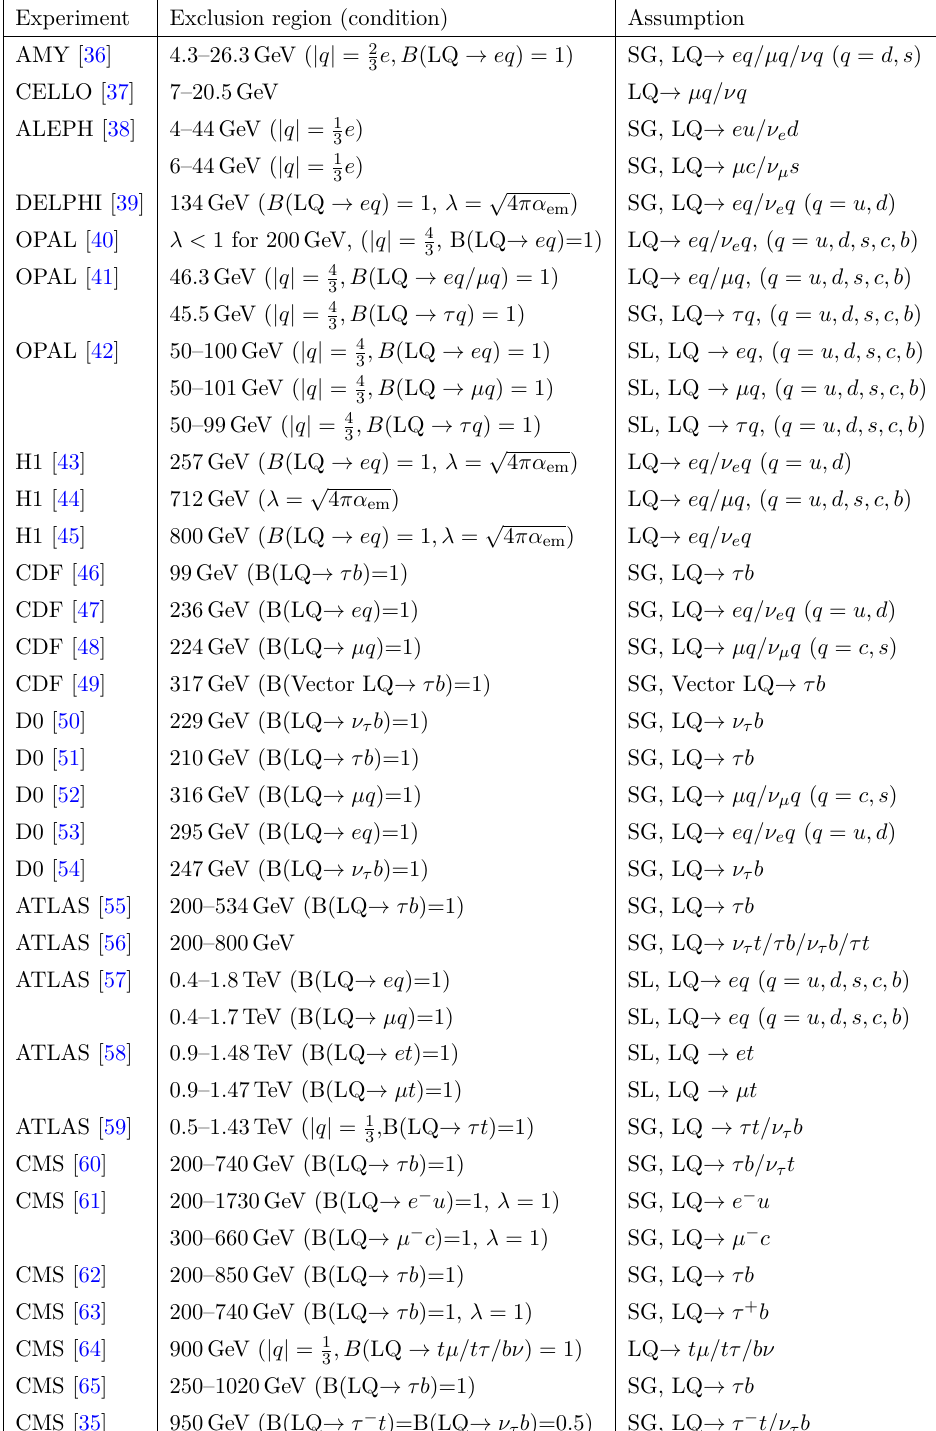
Table 1 . Overview of the experimental searches for the leptoquarks. “SG” represents the assump- tion that a LQ couples to the same generation of fermions. “SL” represents the assumption that a LQ couples to single lepton and all possible quarks. It should be noted that the presented exclusion region may be just part of the experiment